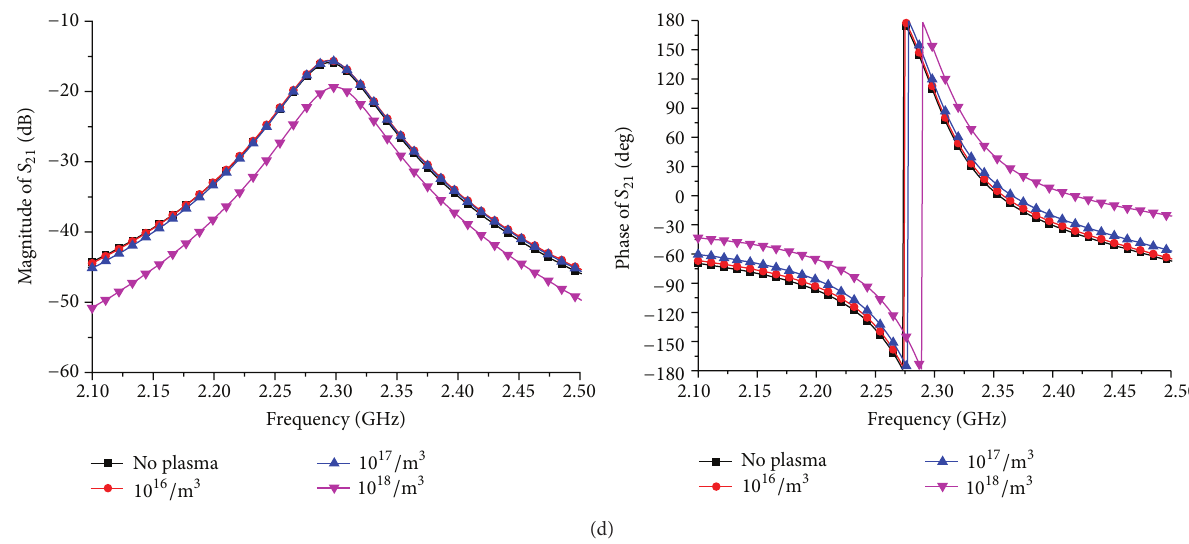
Figure 6: (a) Mutual coupling coefficient ( ] = 0.1 GHz) of adjacent elements. (b) Mutual coupling coefficient ( ] = 1 GHz) of adjacent elements.(c)Mutualcouplingcoefficient( ] = 5 GHz)ofadjacentelements.(d)Mutualcouplingcoefficient( ] = 20